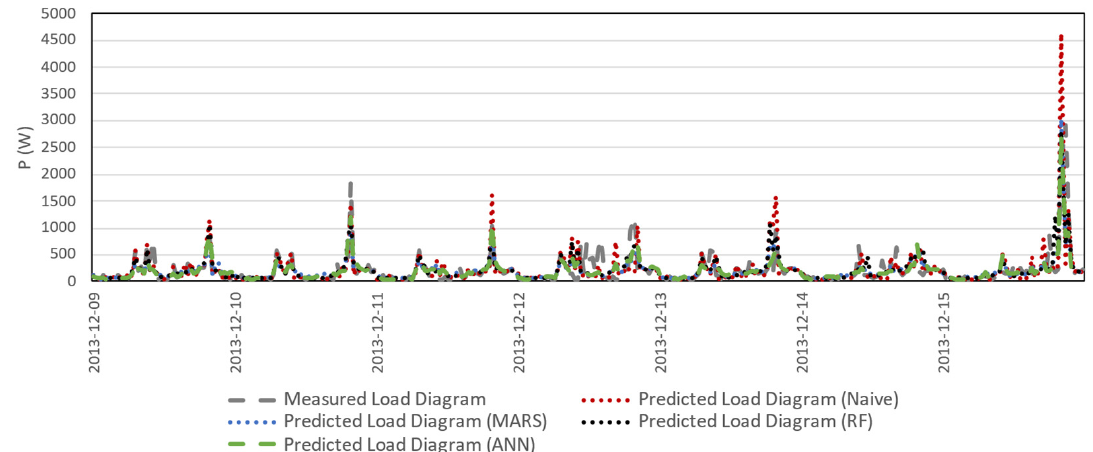
Figure 11. Second comparison of day-ahead predicted and measured load profiles (during a week of the test period)—#Consumer 59.